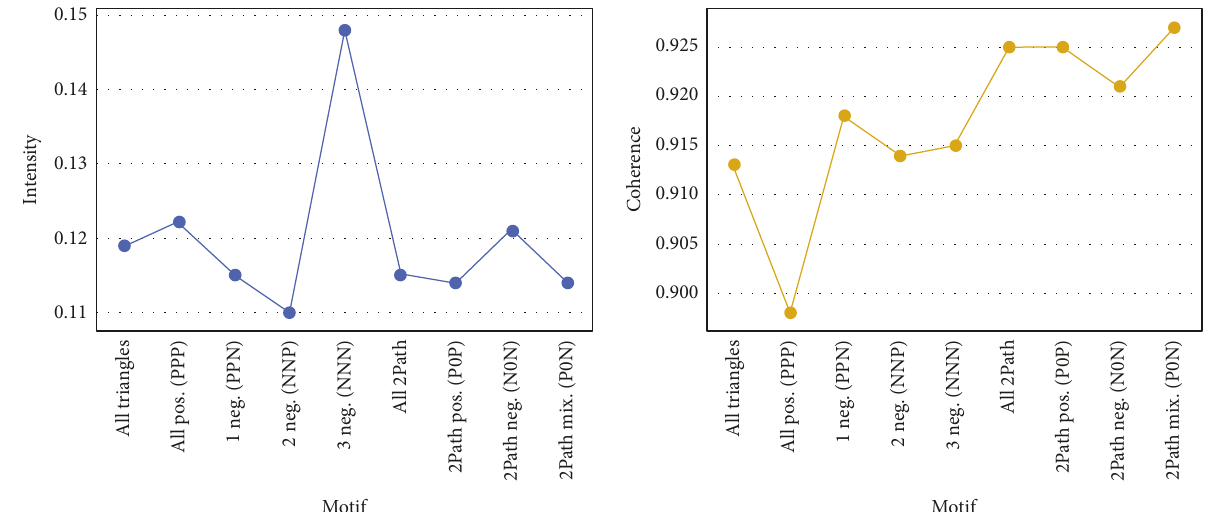
Figure 12: Means of intensity and coherence of all triads and signed motifs in the